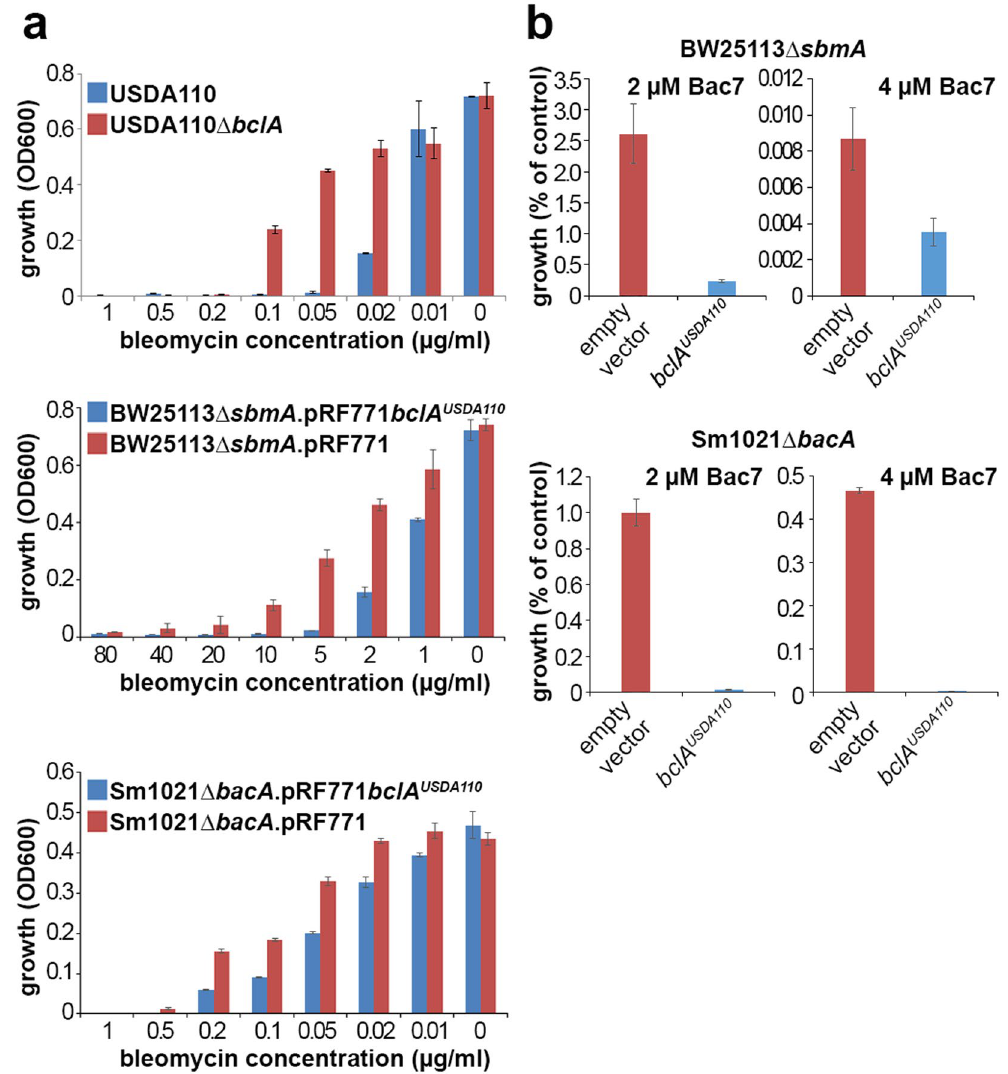
Figure 1. The USDA110 bclA gene confers sensitivity to the antibiotic bleomycin and the antimicrobial peptide Bac7. ( a ) Bleomycin sensitivity in B. diazoefficiens strain USDA110 and its bclA mutant derivative and in E. coli strain BW25113 Δ sbmA and S. meliloti strain Sm1021 Δ bacA carrying an empty vector or a vector expressing USDA110 bclA . Blue bars are for strains expressing bclA and red bars are for strains lacking the gene. Bleomycin concentrations were applied as indicated and growth was determined by optical density measurement at 600 nm with a plate reader after 72 h, 48 h or 24 h incubation for USDA110, Sm1021 and BW25113 respectively. ( b ) Survival of E. coli strain BW25113 Δ sbmA (top) and S. meliloti strain Sm1021 Δ bacA (bottom) derivatives carrying the empty pRF771 plasmid or the USDA110 bclA gene located on plasmid pRF771 after treatment with the peptide Bac7 at the indicated concentration. The surviving bacteria were counted and expressed as % from the water control treatment. Error bars in all panels are standard